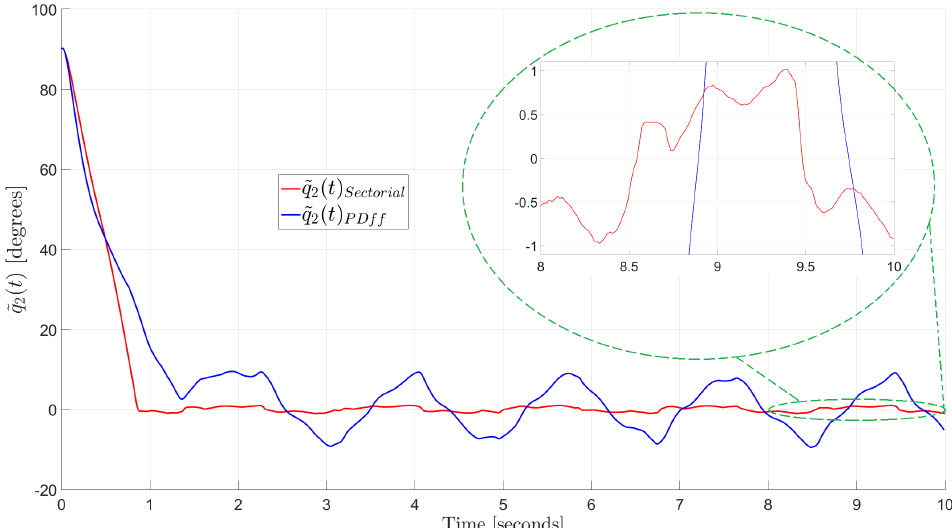
Figure 26. Angular position error for joint